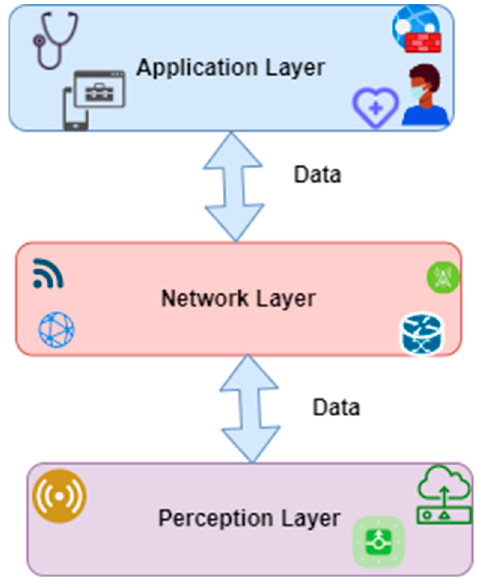
Figure 1. Fundamental architecture of WIoMT [ 18 ]